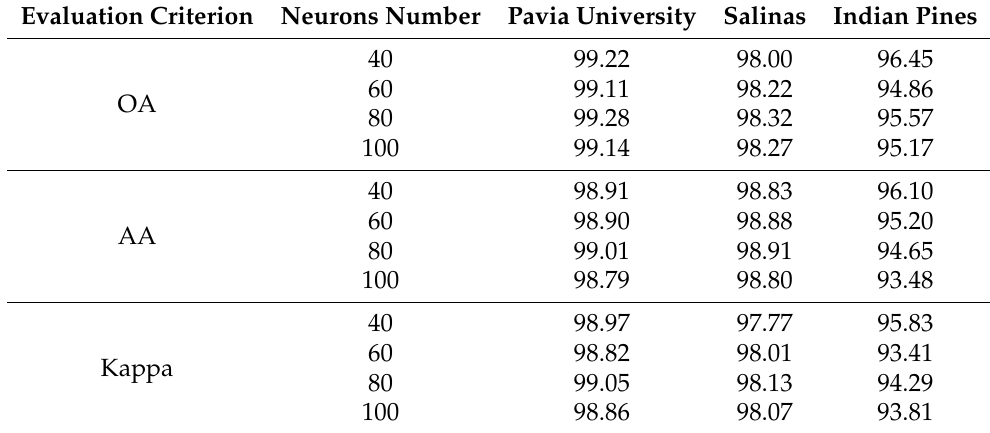
Table 4. Different neuron numbers use AP-SAE model classification results on different data sets.